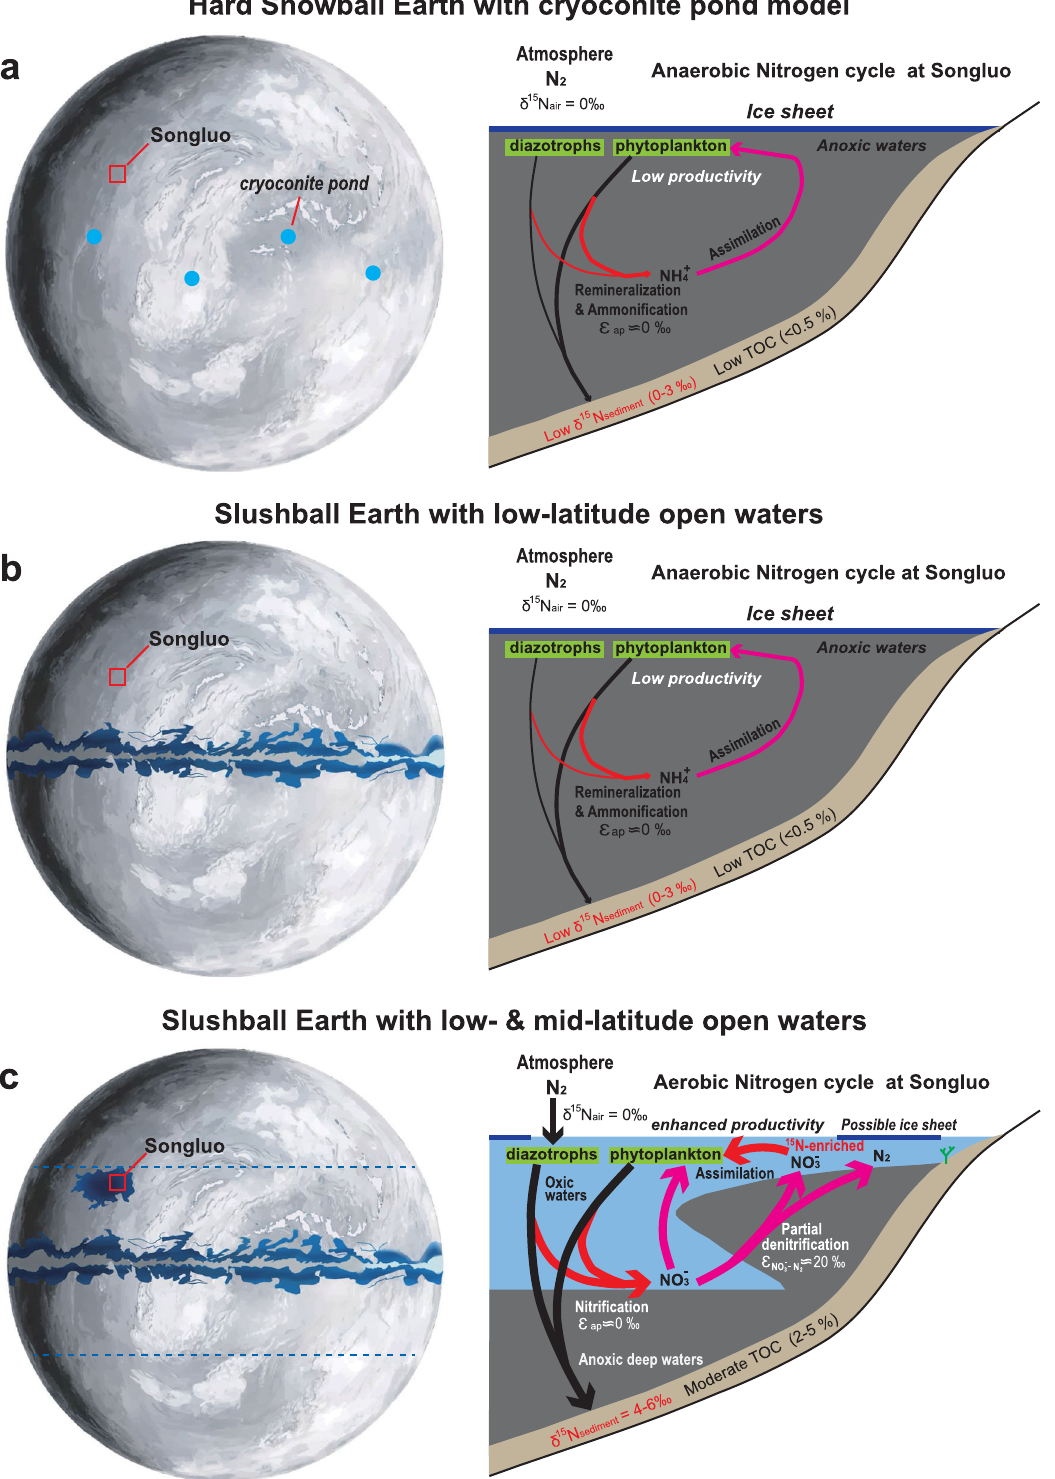
Fig. 3 | Three models of refugia during Cryogenian Snowball Earth glaciation (left) and simpli fi ed model of marine N biogeochemical cycle in mid-latitude oceans during terminal Marinoan Ice Age (right). a Hard Snowball model, in which refugia are limited to cryoconite ponds 10,49 . b Slushball model with a low- latitudeopen-water belt 12,14,16 . c “ Slushball model ” , in which open watersexisted in